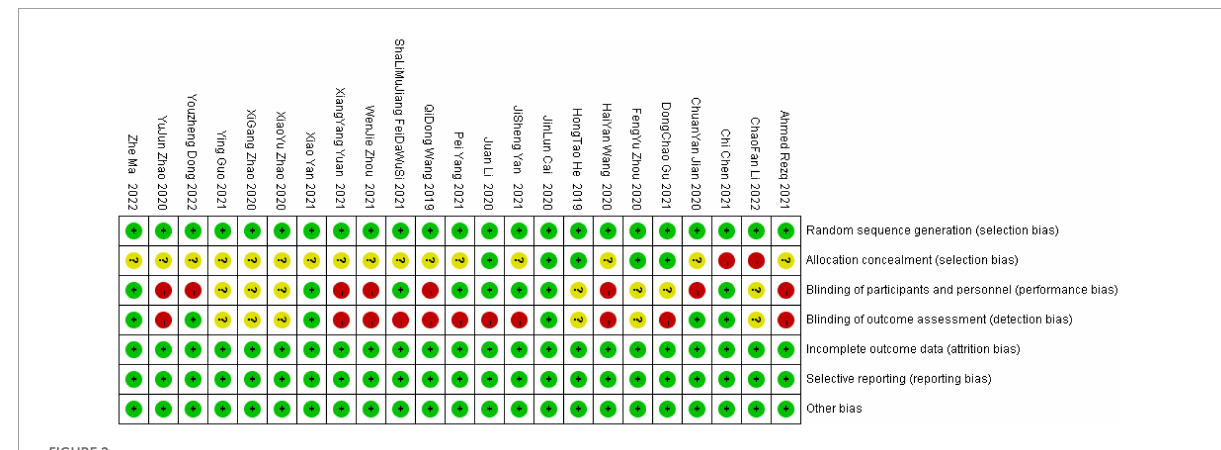
FIGURE2 Risk of bias